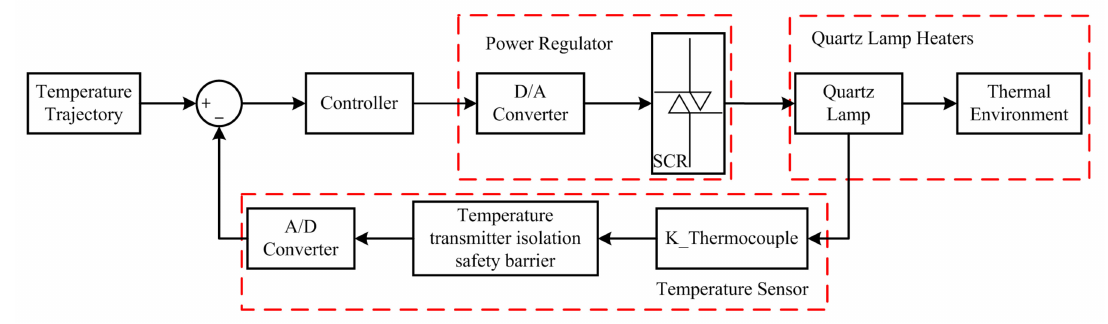
Figure 1. The flow chart of the control system for AHGSHV